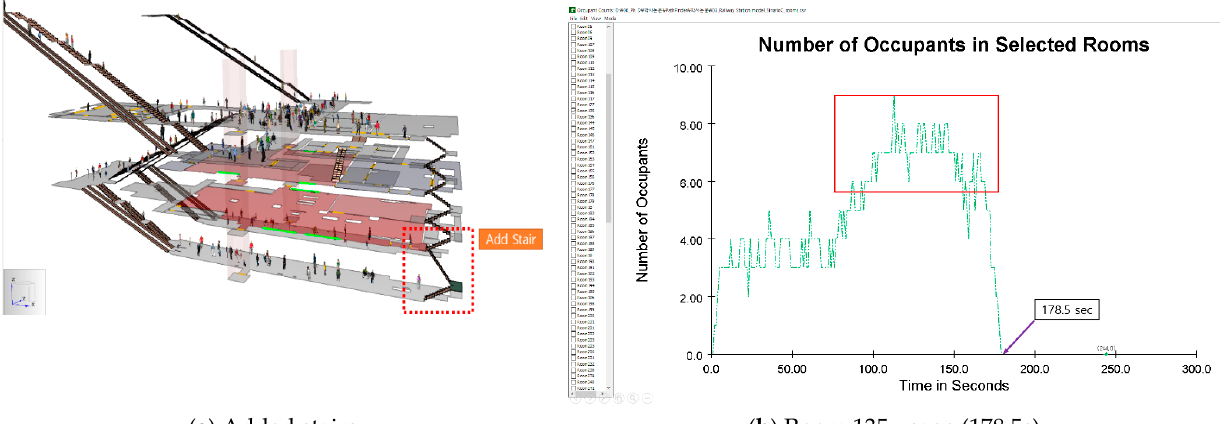
Figure 9. Results of Scenario C.